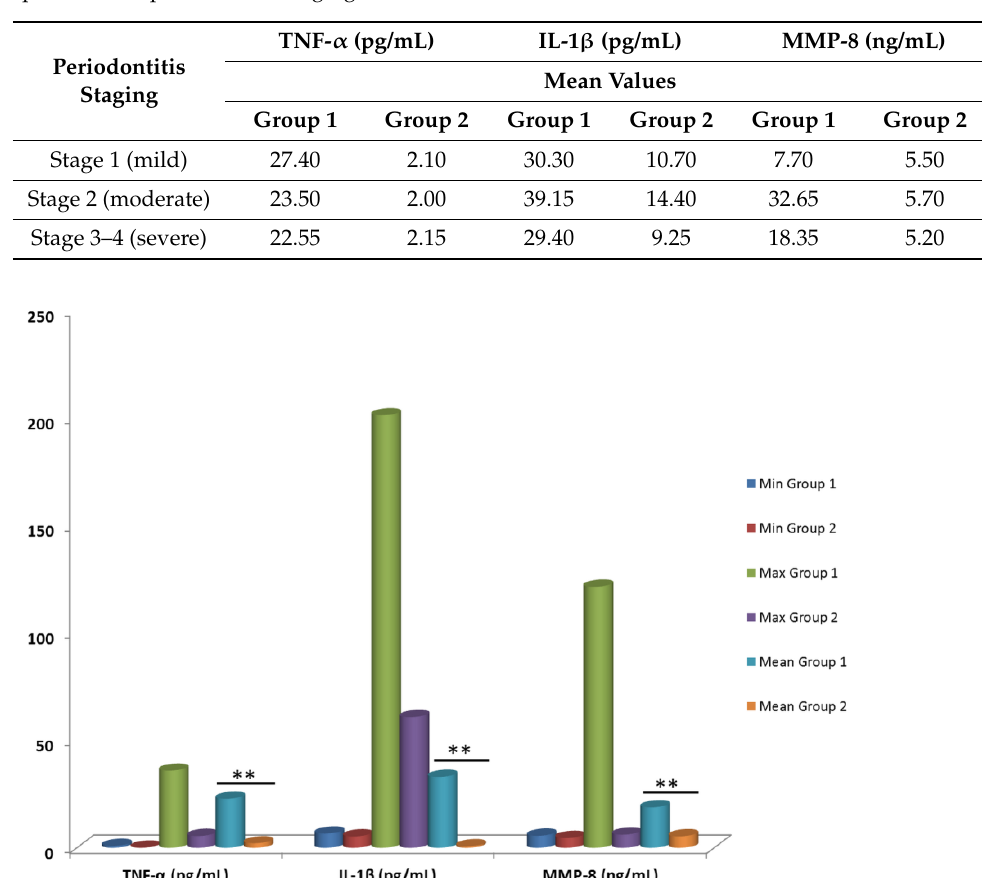
Table 5. GCF immune biochemical biomarker levels in study group versus control group in corre- spondence to periodontitis staging.